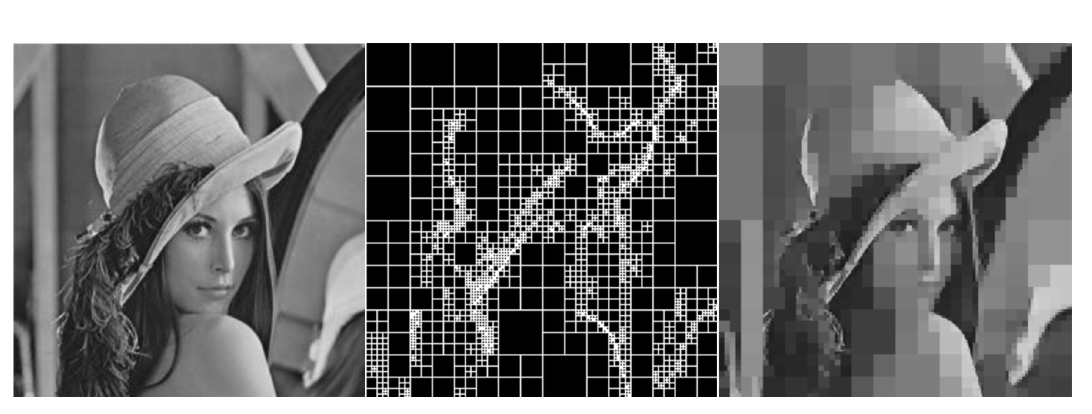
Figure 2 . QTD process with R = 0 : 5 (Left: original image, Middle: QT-decomposed block partitioning, Right: Resulting QTD